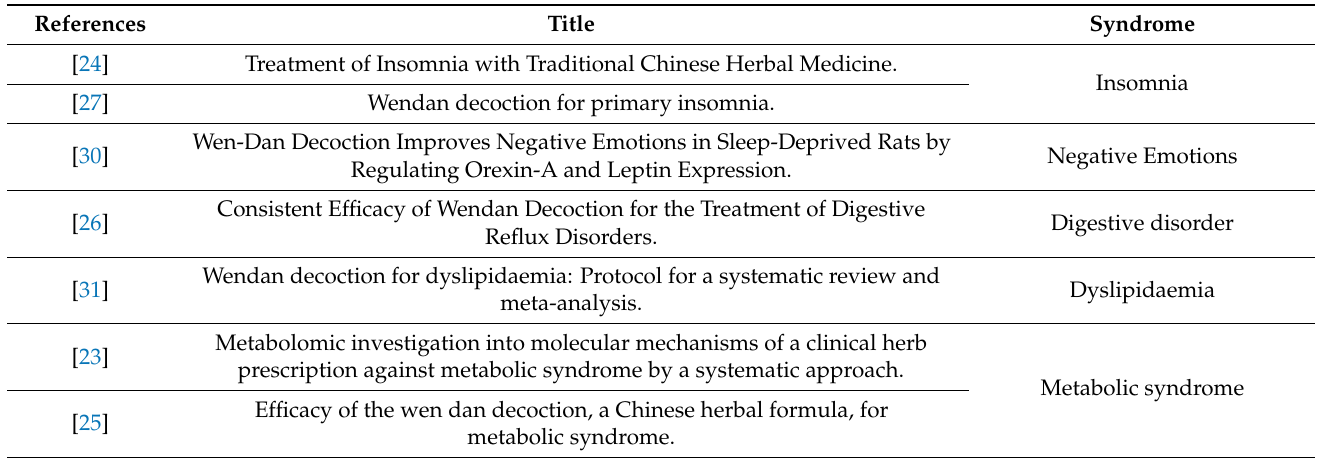
Table 2. Application of WDT in various